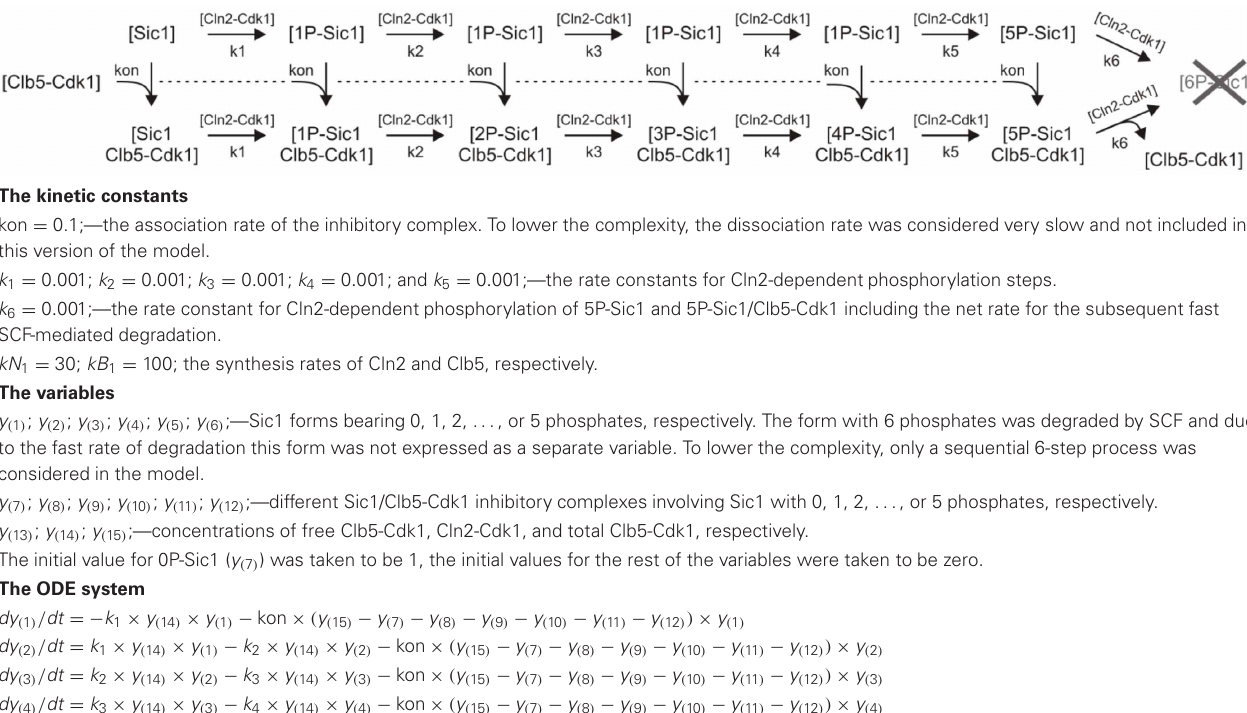
Table 3 | Equation system used for simulation of the time course for Cln2-dependent multisite phosphorylation of Sic1presented in Figure 10B. Scheme